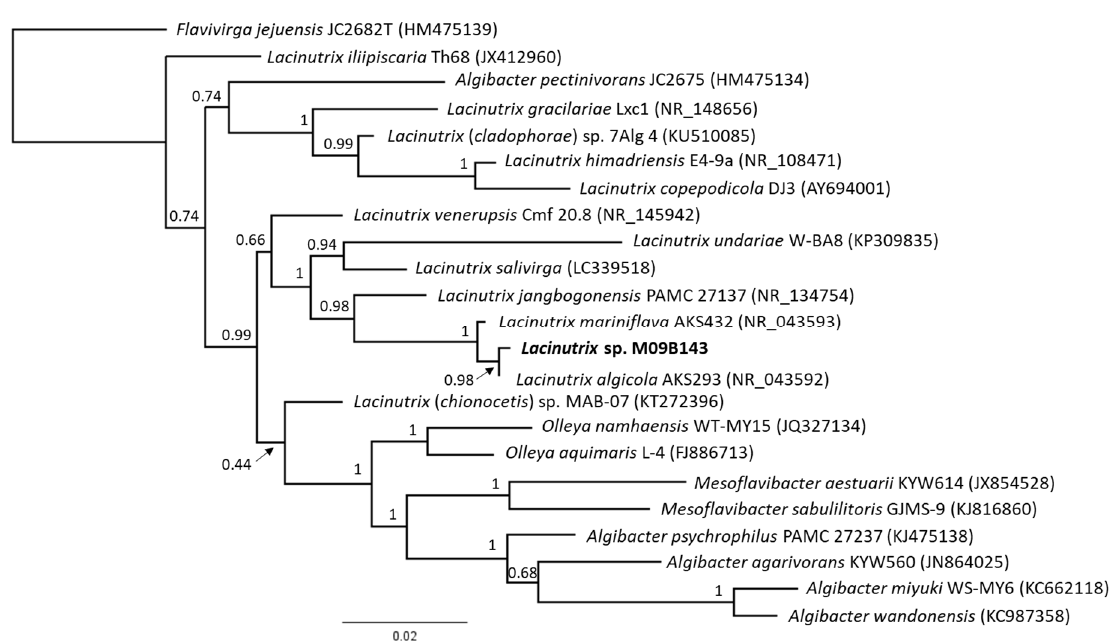
Figure 1. Maximum likelihood tree based on 16S rRNA gene sequences and showing the phylogenetic placement of the strain M09B143 (in bold) within Bacteroidetes. The tree was rooted with Flavivirga jejuensis as the outgroup. Branch support is given as aLRT values.